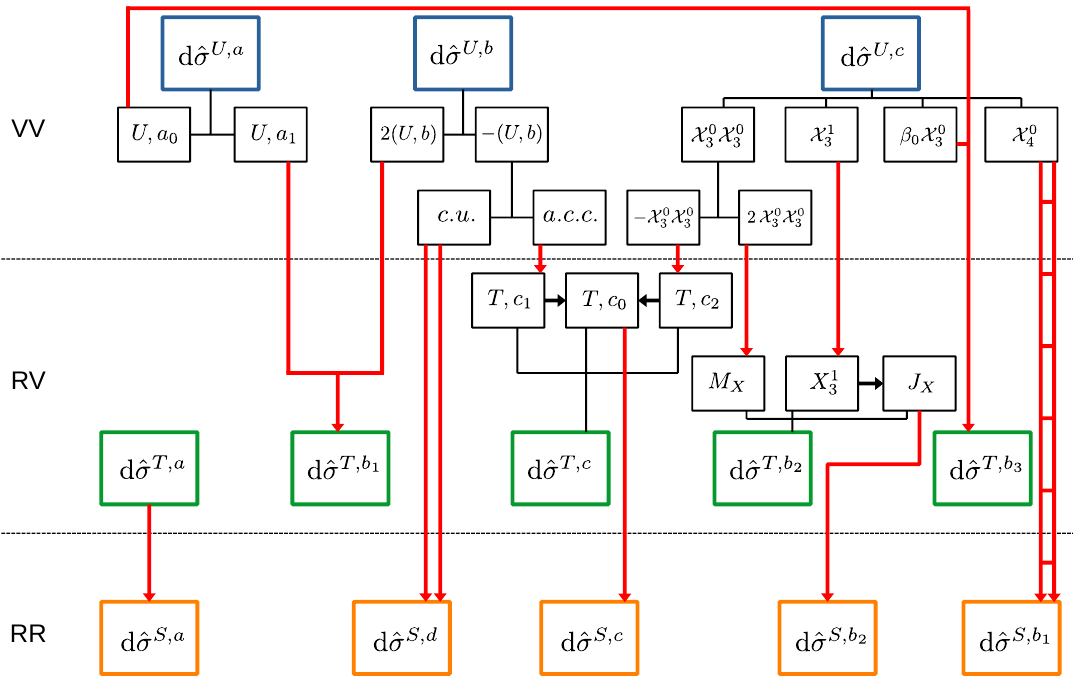
Figure 1 . Structure of colourful antenna subtraction at NNLO. Descendant red arrows represent the transition from an integrated quantity to its unintegrated counterpart via single insertion (single arrow), double iterated insertion (two disjoint arrows) or double simultaneous insertion (two connected arrows) of unresolved gluons. The definitions of each component are listed in table 2.